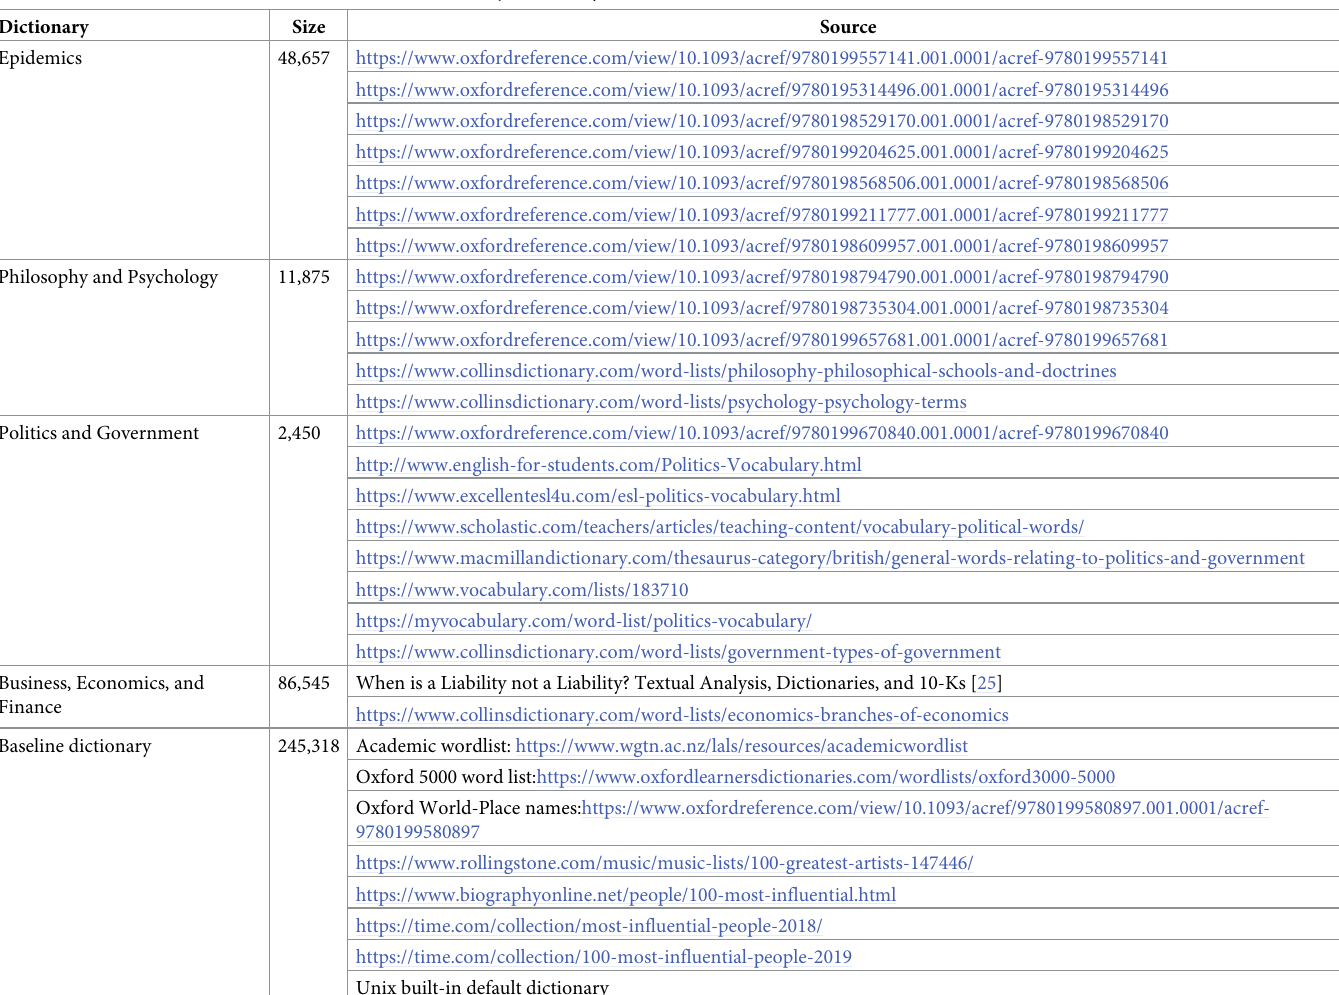
Table 2. Details of the sources we used to build our dictionary. Dictionary size is measured in number of words. Dictionary